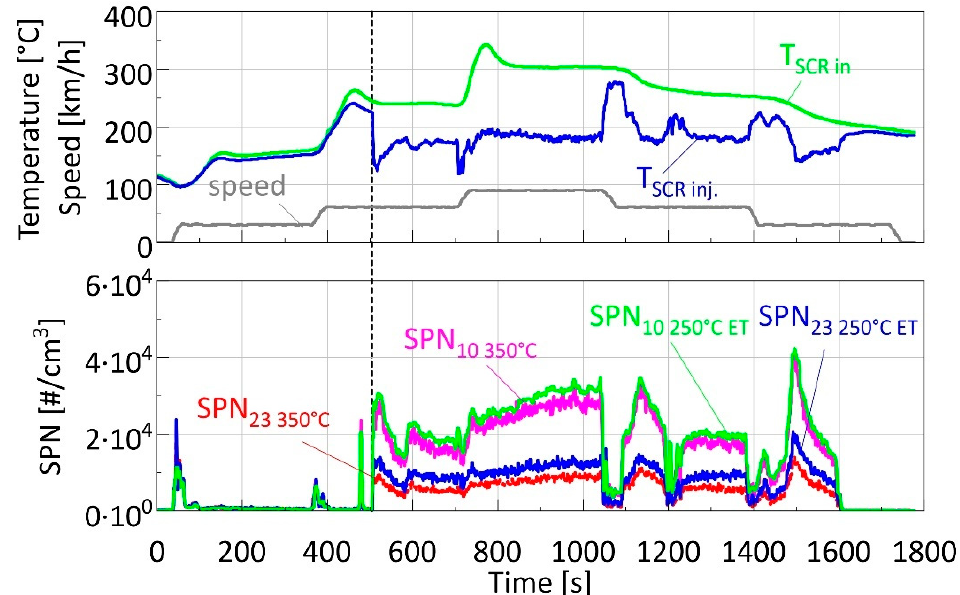
Figure 9. SPN concentrations (bottom panel) at the outlet of the SCR during the speed ramp tests as measured with CS 2 at its default VPR operating temperature of 350 °C and ET system set at a VPR temperature of 250 °C. The corresponding velocity profile as well as the temperatures measured at the inlet of the SCR and in front of the urea injector are shown on the top panel. The dashed vertical line only serves as a guideline depicting the start of urea injection based on the temperature measurements. CS = Catalytic Stripper; ET = Evaporation Tube; SCR = Selective Catalytic Reduction; VPR = Volatile Particle Remover.